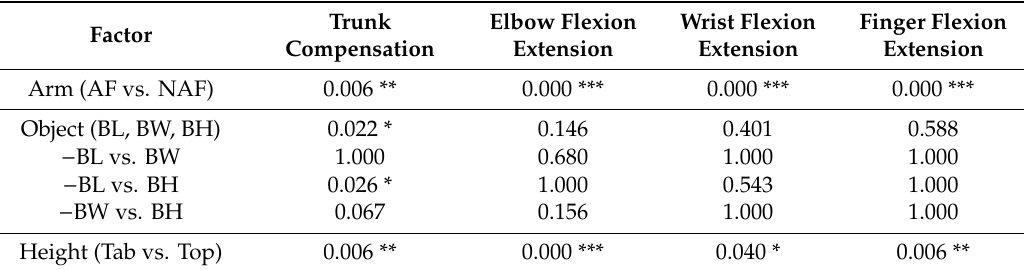
Table 3. Statistical significance of the e ff ects of the independent fixed factors arm, object, and height on the dependent variables of the selected joint range metrics. The factor object including post-hoc pairwise testing between the three levels (BL, BW, BH). Trunk Factor